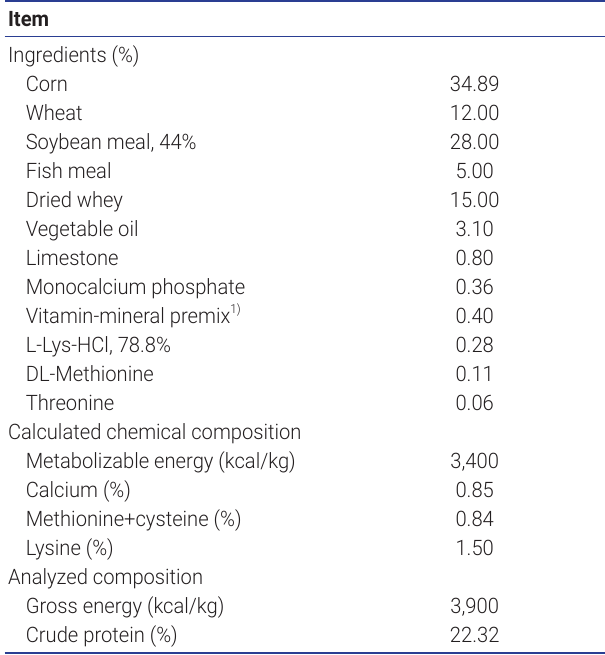
Table 1. Ingredient and nutrient composition of the experimental diet (as-fed